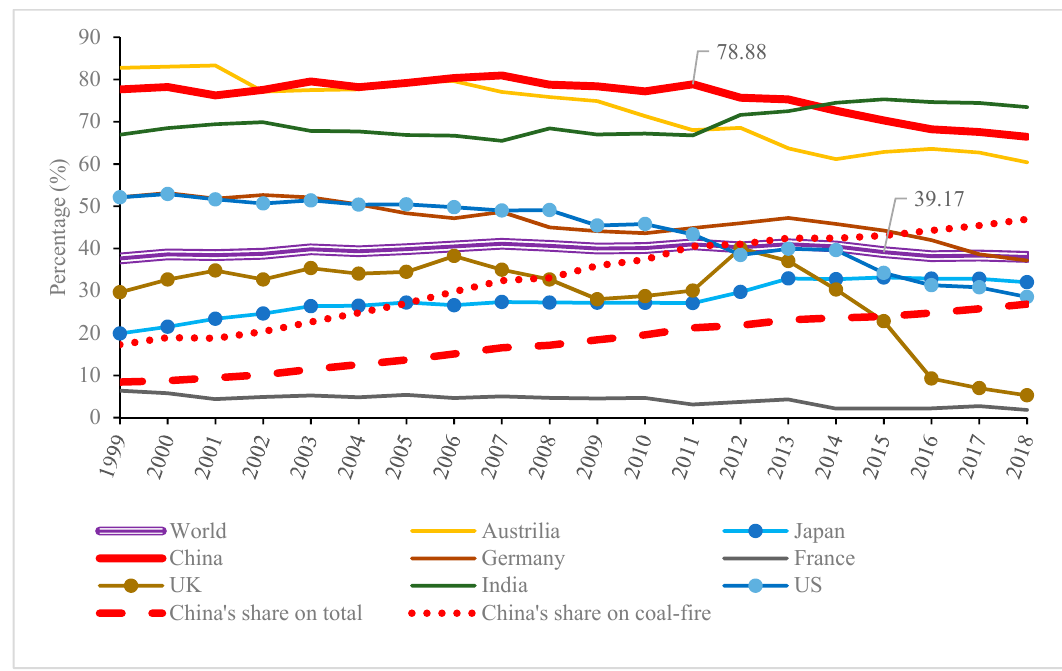
Figure 2. Proportion of coal-fired power generation to total power generation from 1999 to 2018 (data source: World Bank/International Energy Agency).